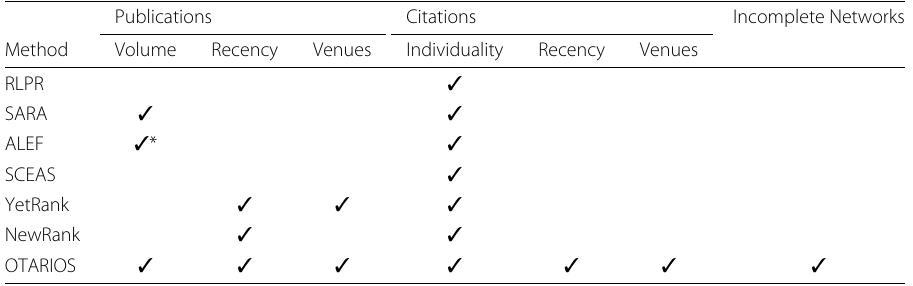
Table 2 Comparison of state of the art methods with OTARIOS Publications Citations Method